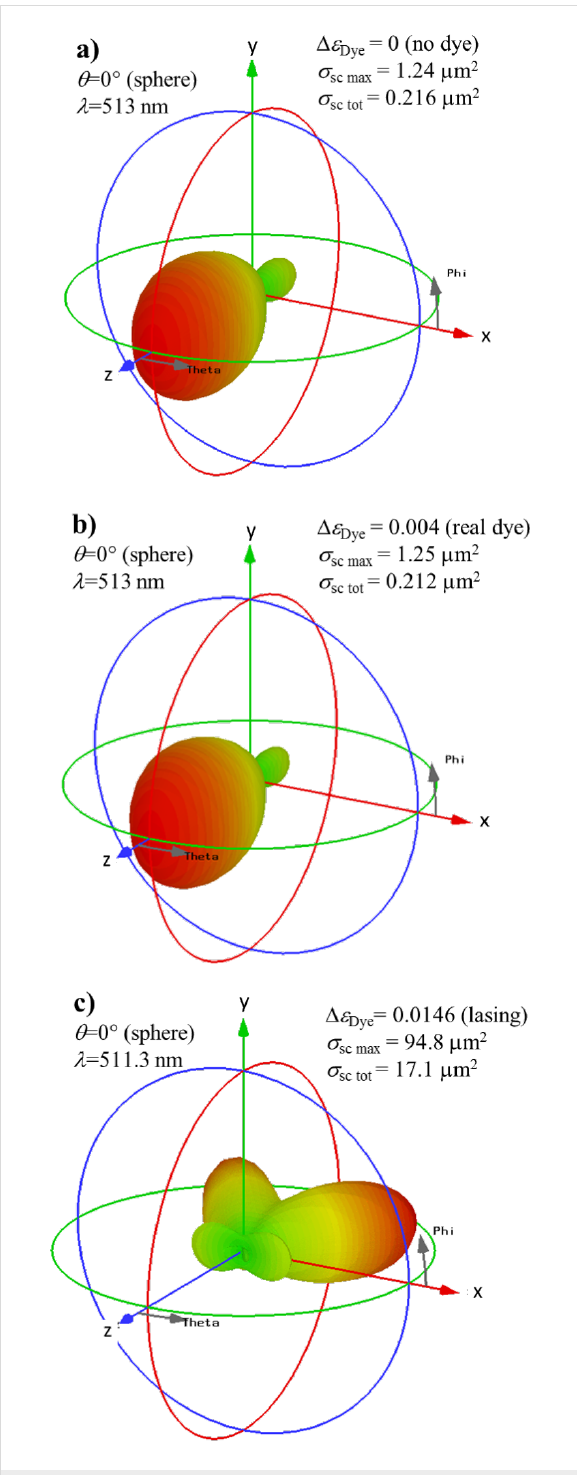
Figure 7: Differential scattering cross section σ sc , linear scale, for resonant semi-shells with thickness h = 16 nm at λ ≈ 513 nm. The ir- radiation is from the (0,0) direction; the strength of the emission (gain, A = 0, E = 1) is (a) Δε Dye = 0 (no dye molecules at all), (b) 0.004 (commercially available dye concentration and total inversion) and (c) 0.0146 (lasing condition). The maximum of the differential and the total σ sc are given in the